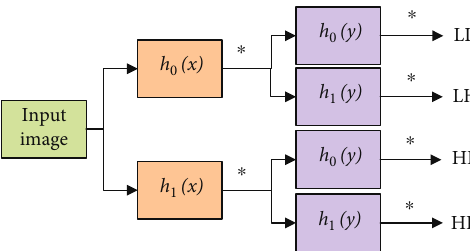
Figure 1: Flow chart of 2D discrete wavelet decomposition calculation.